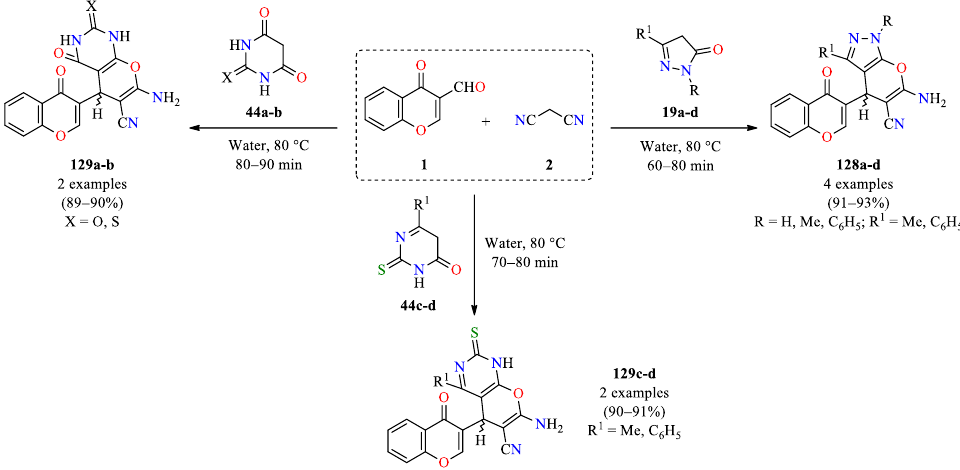
Scheme 16. Three-component synthesis and anticancer activity of new 4-(4-oxo-4 H -chromen-3-